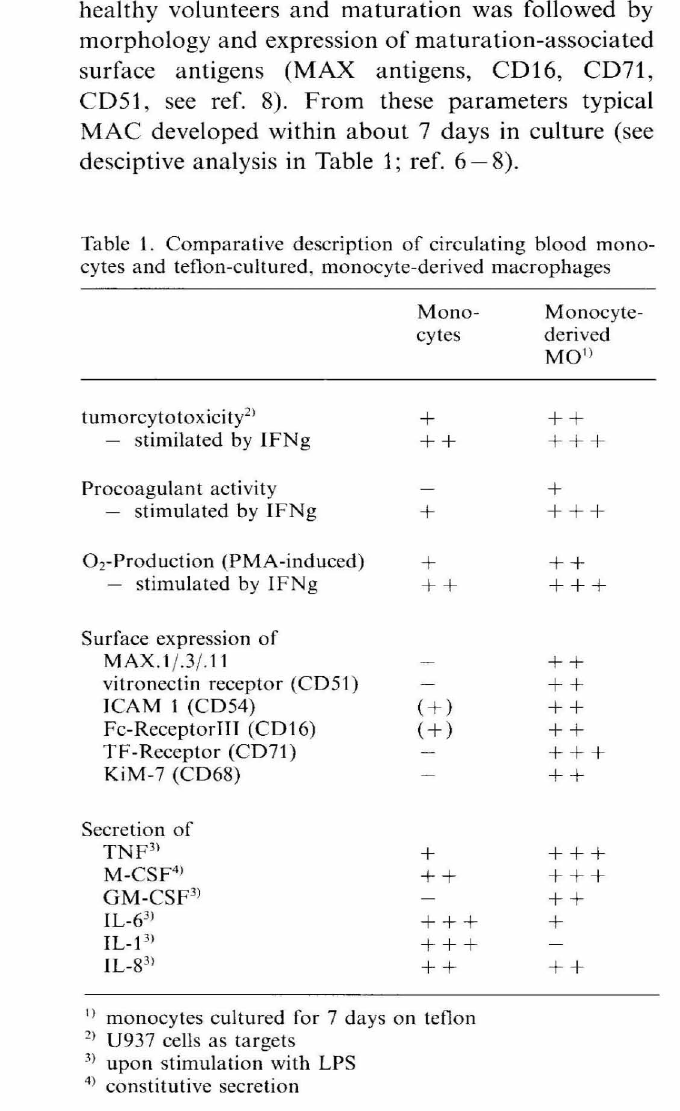
Table 1. Comparative description of circulating blood mono cytes and teflon-cultured, monocyte-derived macrophages